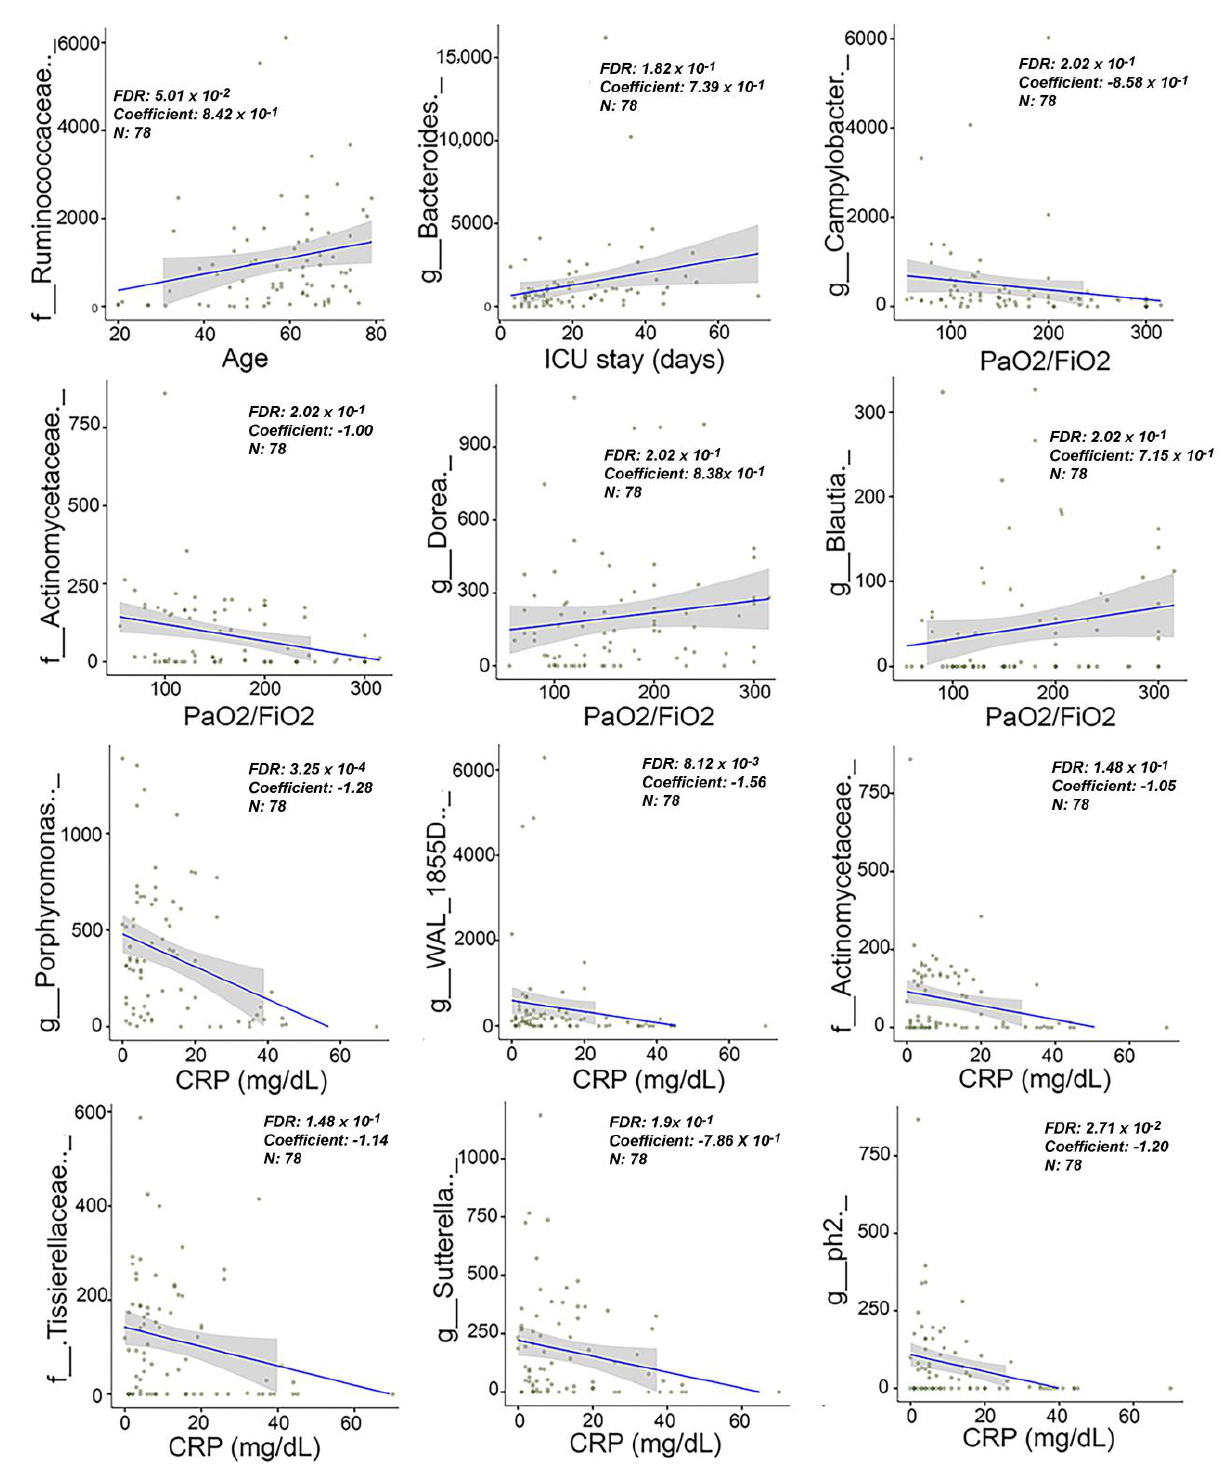
Figure 5. Association between clinical and laboratory data and gut microbiome composition data at baseline using MaAsLin2. Only significant results are shown (FDR < 0.25 are specified for each association). Gut microbiome data are plotted in raw counts.